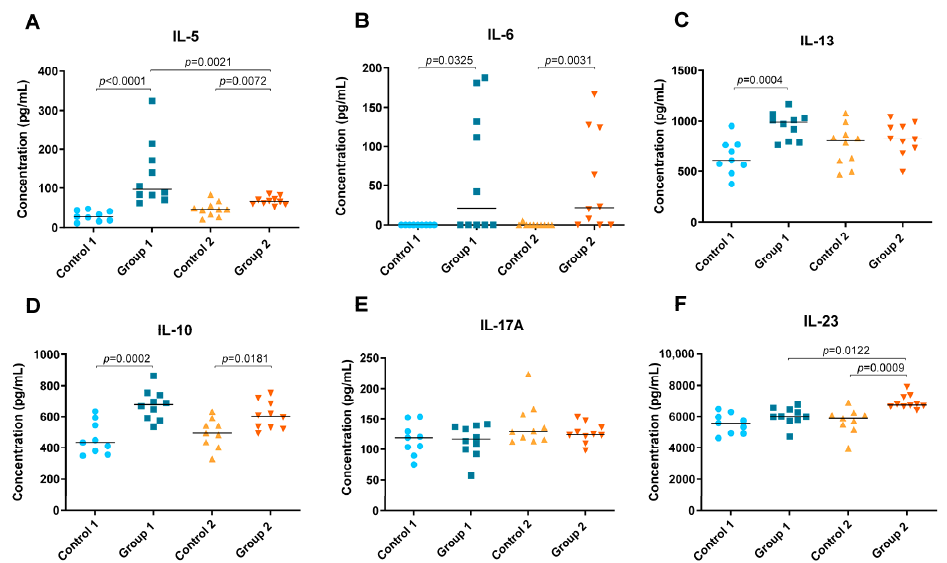
Figure 5. Th2 and Th17 cytokine concentration (pg/mL) in lung tissue homogenate. In each group, data are shown as individual and median values of IL-5 ( A ), IL-6 ( B ), IL-13 ( C ), IL-10 ( D ), IL-17A ( E ) and IL-23 ( F ).